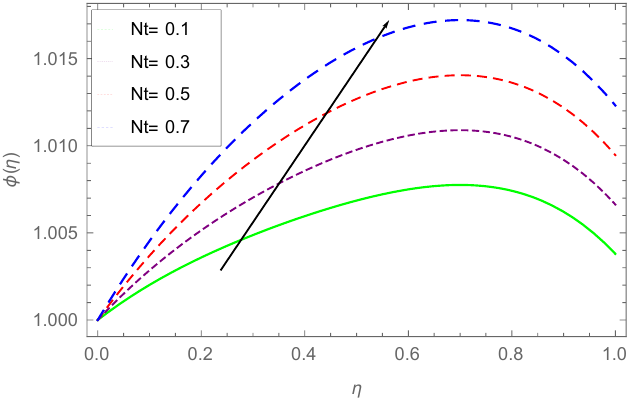
Figure 15. Impact of Nt on φ ( η ) , when St = 0.1, Sc = 0.5, Nb = 1.2, β =